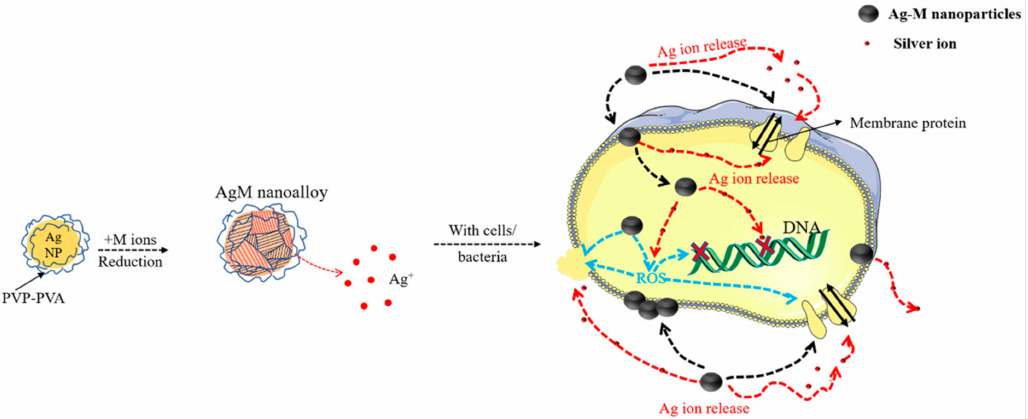
Figure 10. The proposed toxicity mechanism of AgM